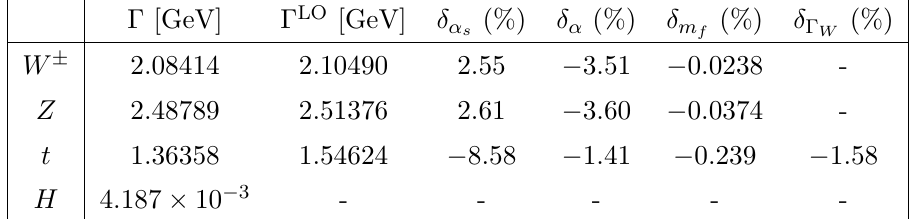
Table 7. SM-particle widths computed by SMWidth in the (cid:11) ( m Z )